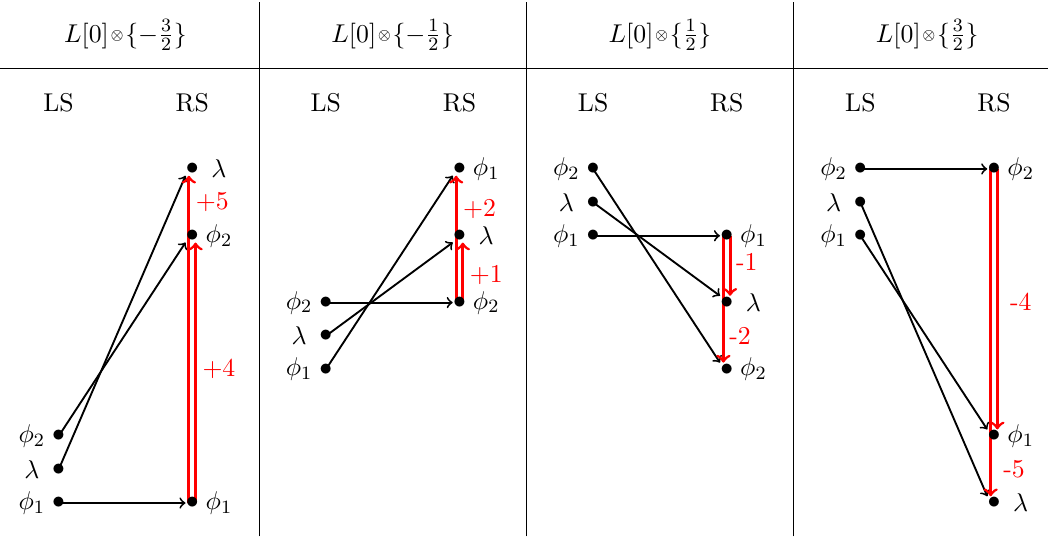
Figure 7 . Shift patterns of the conformal dimensions of the states within L [0] , as we go from the left- to the right-squashed S 7 . Here, λ is a fermion with spin 1